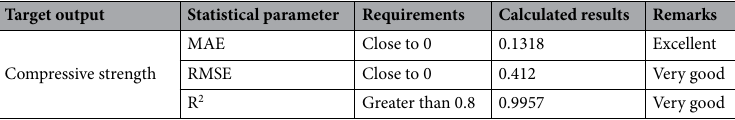
Table 8. Performance evaluation of ANFIS model.